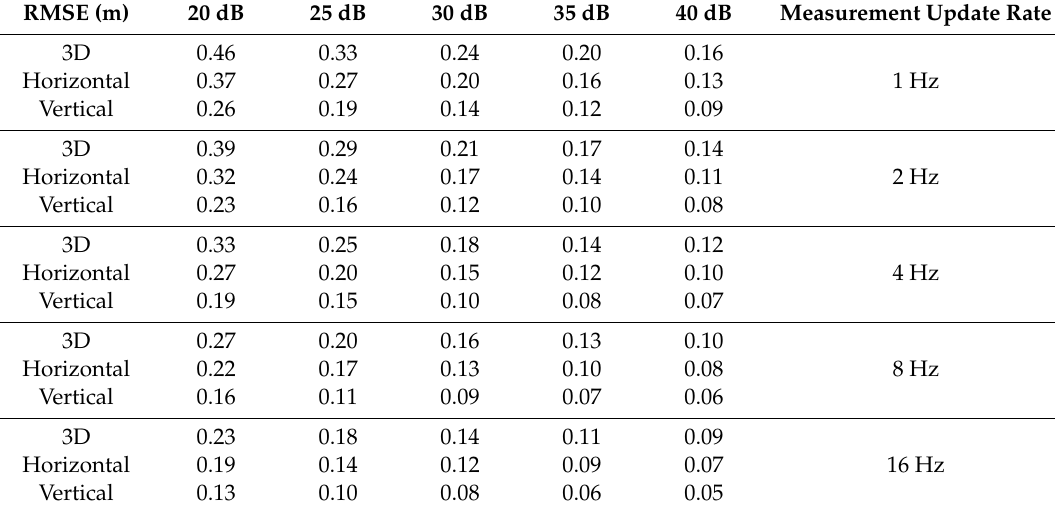
Table 2. Best accuracies obtained at all investigated signal-to-noise ratio (SNR) levels and measurement update rates in the 3D linear path experiments.